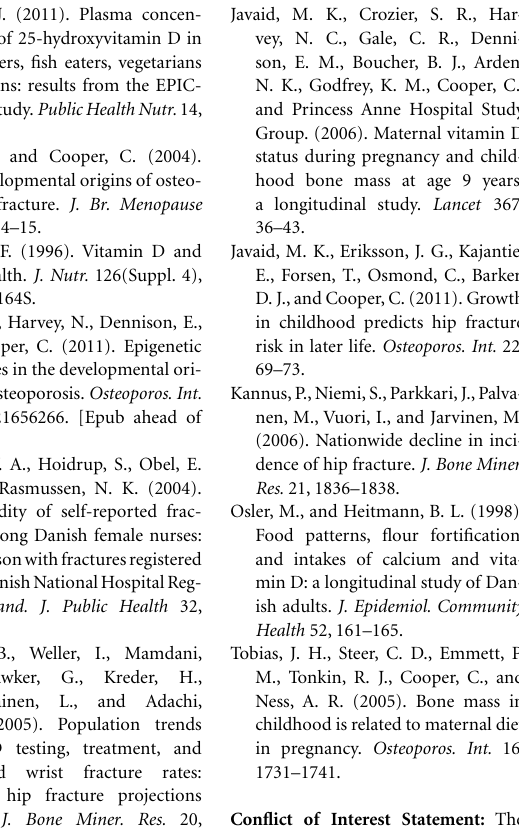
algorithm. Adjusting results for early manifestations of